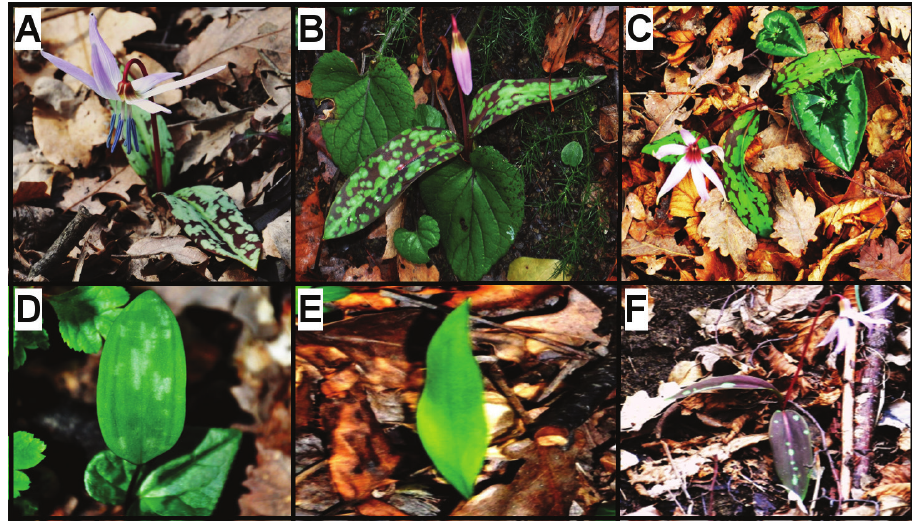
Figure 4. Different patterns of E. dens-canis leaves. A Silvery pictorial pattern (SLV-PC) characterized by red-brown (and later green) drawings on a grey-silvery background (Feb. 27, 2015) B Silvery-and-green chess- like leaves with red-brown spots (S&G-CH, Feb. 13, 2016) C Green-mottled leaves with red-brown spots (GRN-MO, Feb. 24 th , 2016) D A rare rusty variant of SLV with red-brown leaves (Mt. Adone, 550 m of altitude, March 15, 2015) E A juvenile leaf with clear-silvery spots on green background (GRN-CS, April 11, 2015) F Juvenile lanceolate (JUV-LA) uniformly green (GRN-UN) leaf. Photos taken at Farneto (except D